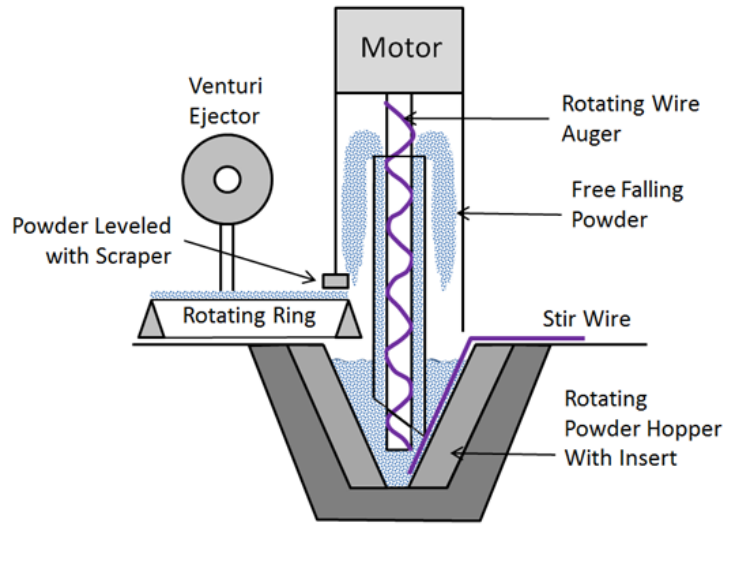
Figure 1. Dust generator schematic diagram (not to